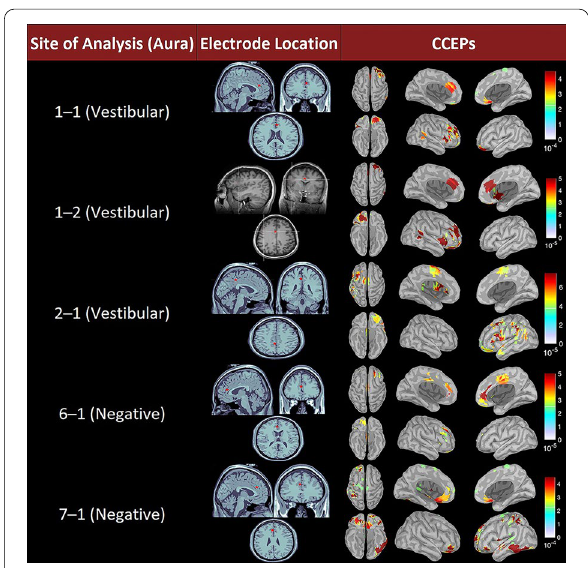
Fig. 3 CCEP stimulation sites and average record evoked responses as root mean square as μV 2 /s